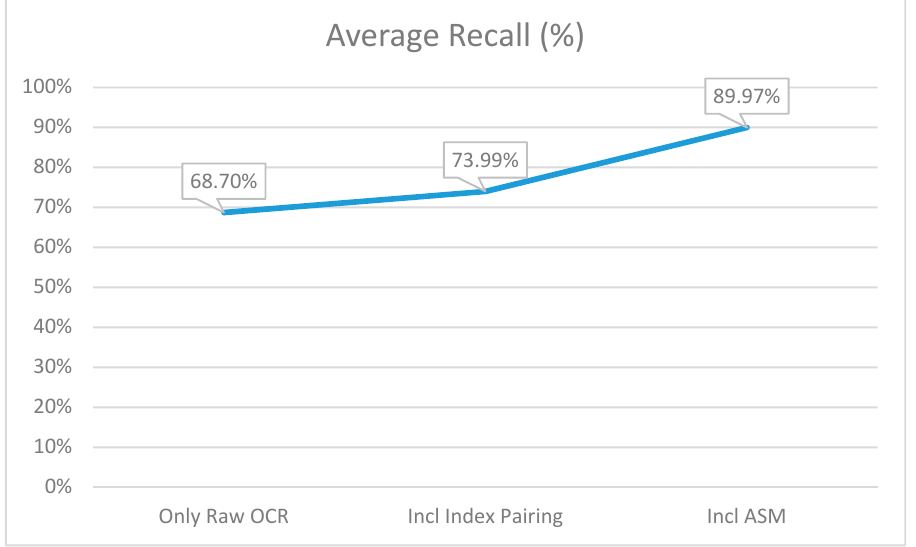
Figure 8. The average recall percentage at each of the three points of capturing the metrics.